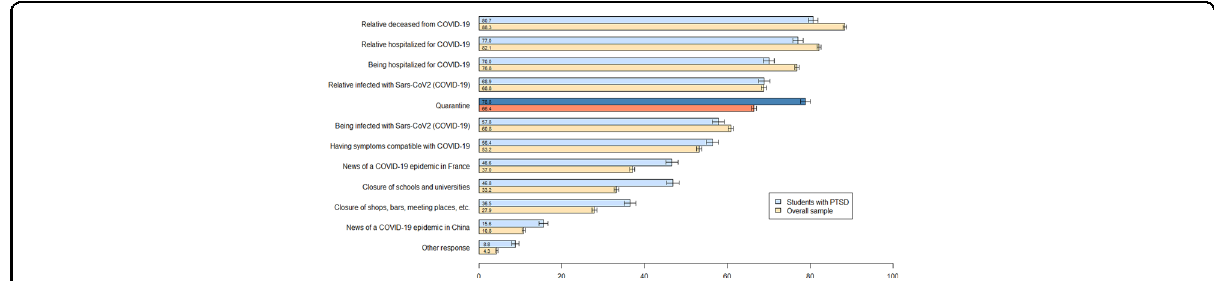
Fig. 1 Proportions of students considering COVID-19-related events as potentially traumatic. A list of pandemic-related events was presented to the students. They were asked, for each event, to indicate if they considered it as traumatic (i.e., likely to endanger the life or the physical or psychological integrity of a person who is exposed to it). In yellow, the proportions of students answering “ yes ” among the whole sample. In blue, the proportions of students answering “ yes ” among those with a probable PTSD (as assessed by a PCL-5 score above 32). Quarantine, event of interest in our study, is